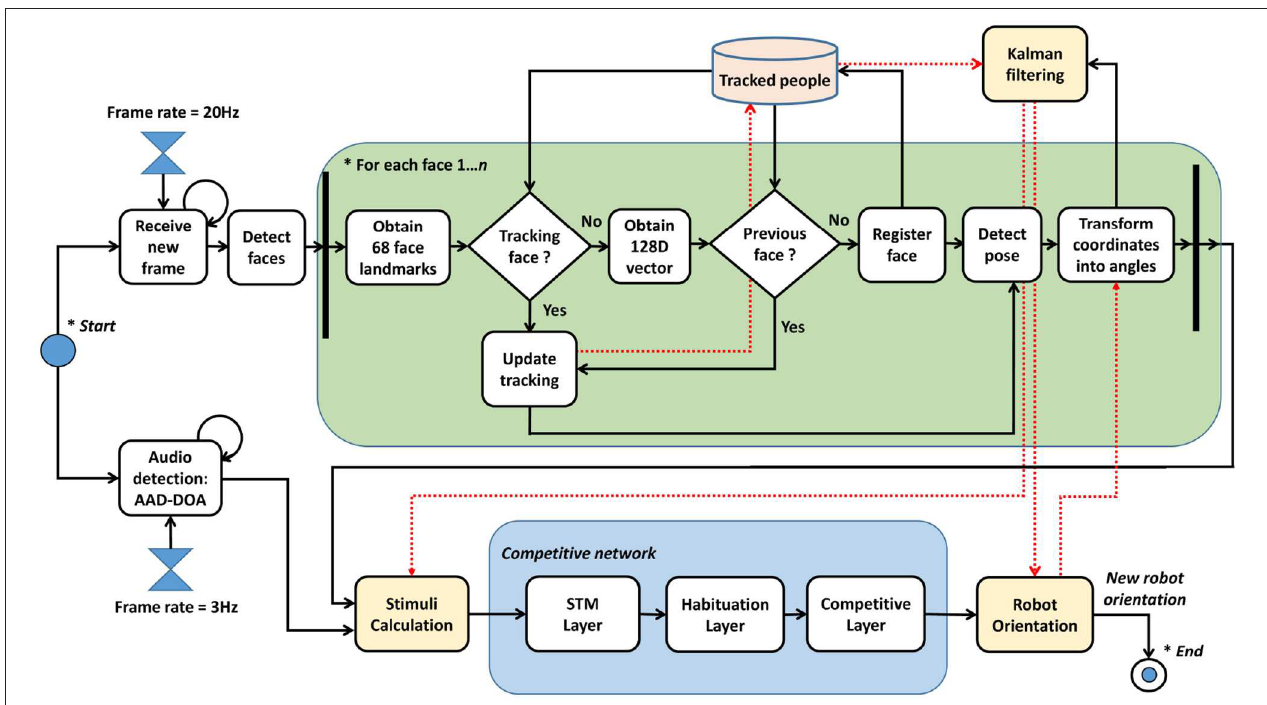
FIGURE 1 | Steps in the gaze control